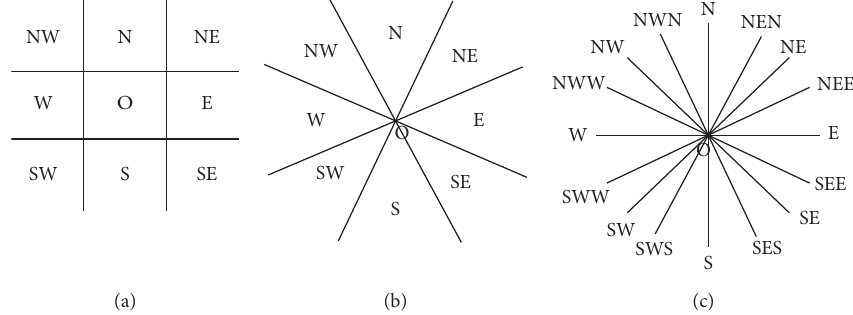
Figure 3: (a) The MBR model, (b) 8-direction model, and (c) 16-direction model.